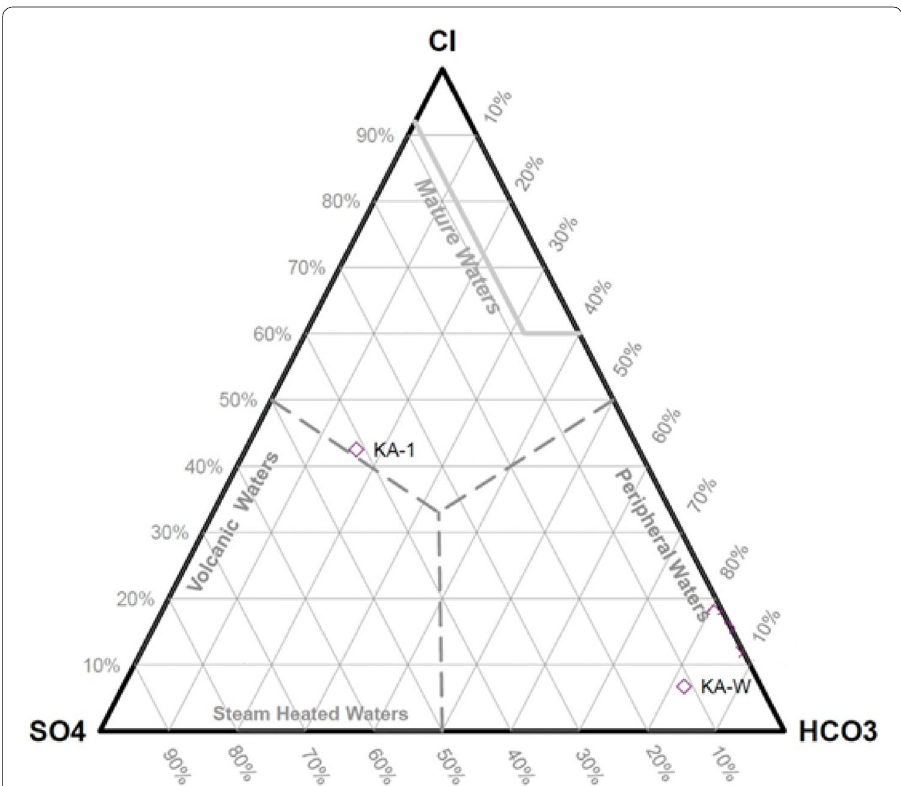
Fig. 4 KA-1 and KA-W samples plotted on Giggenbach (1988) Cl, SO 4 , and HCO 3 triangular graph